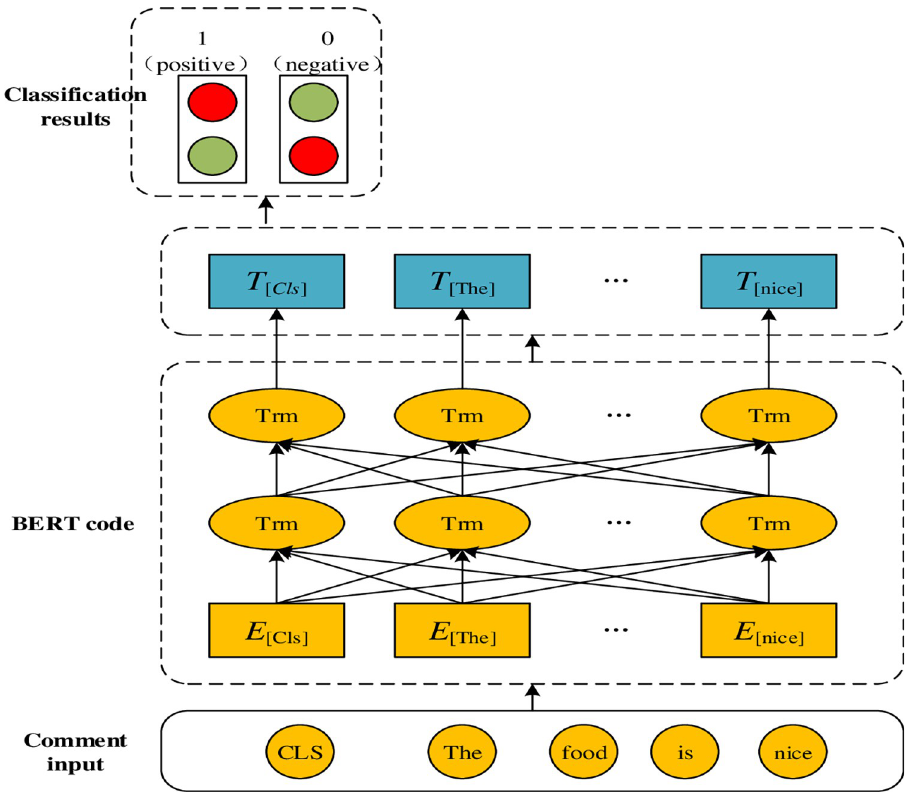
Fig 4. BERT classification